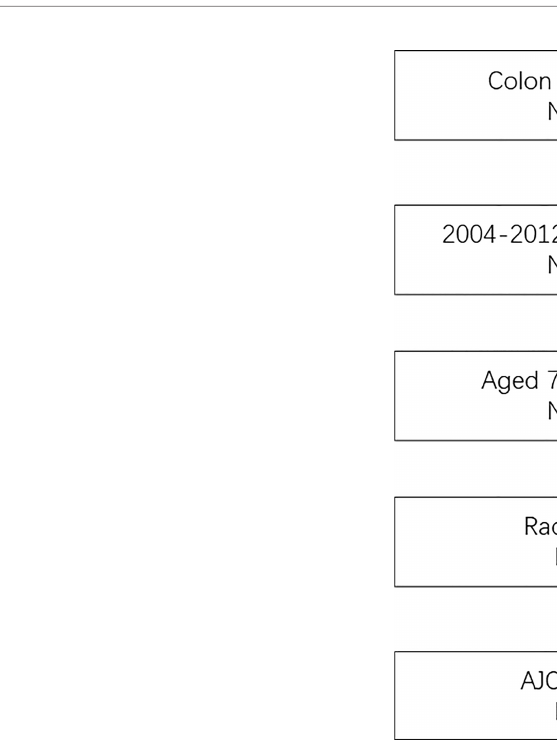
FIGURE 1 | Flowchart of cohort ascertainment in this study. We included 69,946 stage II/III patients aged 70 years or older diagnosed with colon cancer between 2004 and